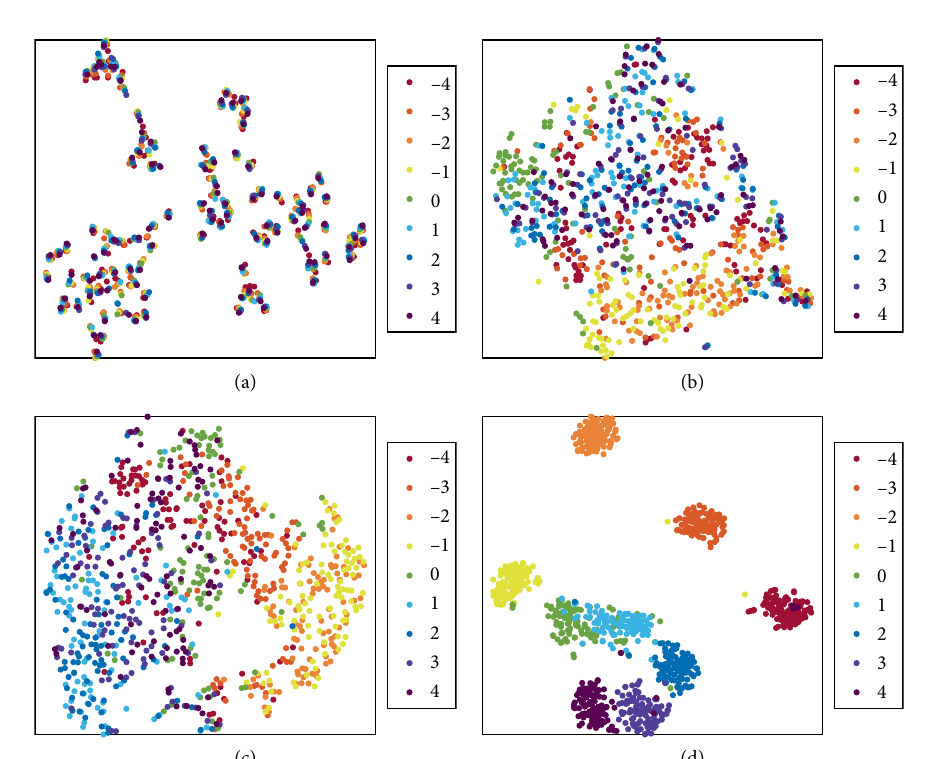
Figure 5: Visualization of different feature maps by t -SNE. (a) The first derivative of LFCC. (b) Output feature map of first Conv group in CNN. (b) Output feature map of second Conv group in CNN. (c) Output feature map of last Conv group in